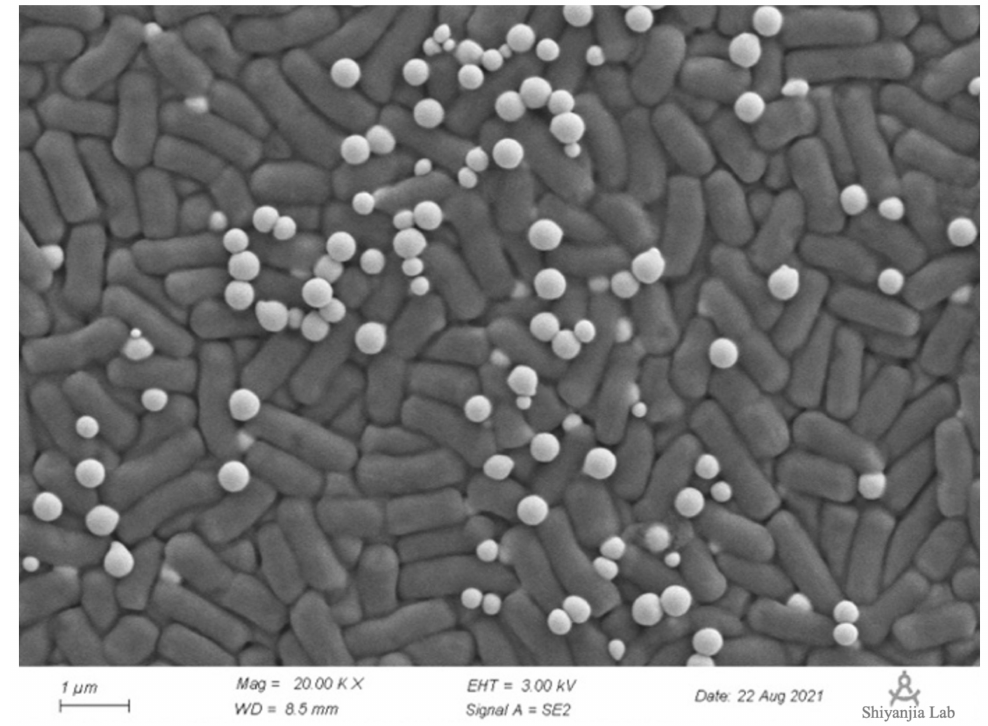
Figure 6. Scanning electron microscopy (SEM): strain Y4 with 50 mM selenite after 24 h of